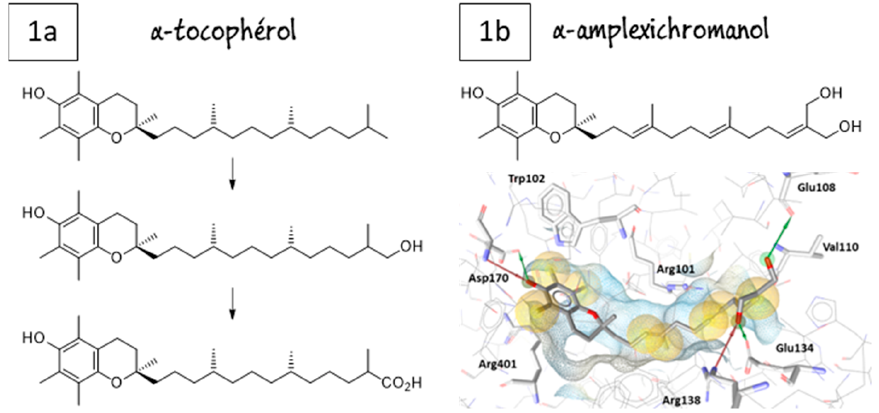
Figure 43. ( 1a ) From α -tocopherol to the corresponding ω -alcohol and ω -carboxylic acid. ( 1b ) α -amplexichromanol (structure and pose/interactions within the allosteric site of 5-LOX).